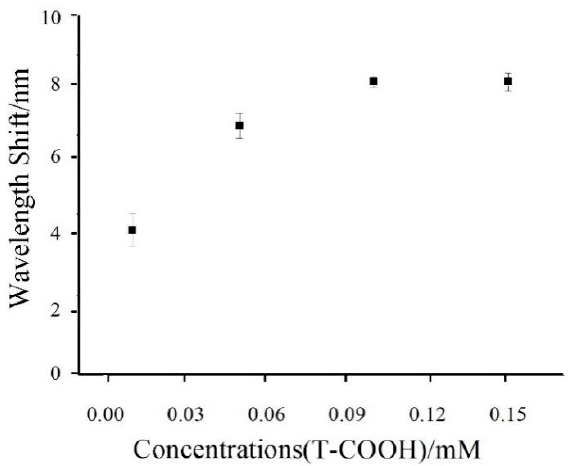
Figure 7. The optimization concentrations of T-COOH for the modification of a fiber-optic sensing